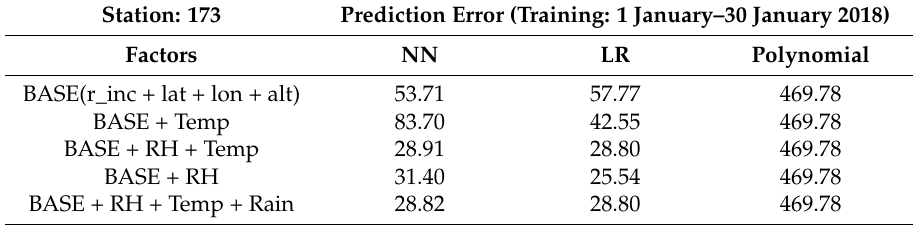
Table 7. Task 3: prediction error of the sensor attribute r_inc coming from monitoring station 173 using neural network, and linear and polynomial regression machine learning models on the IoT Sensors dataset.